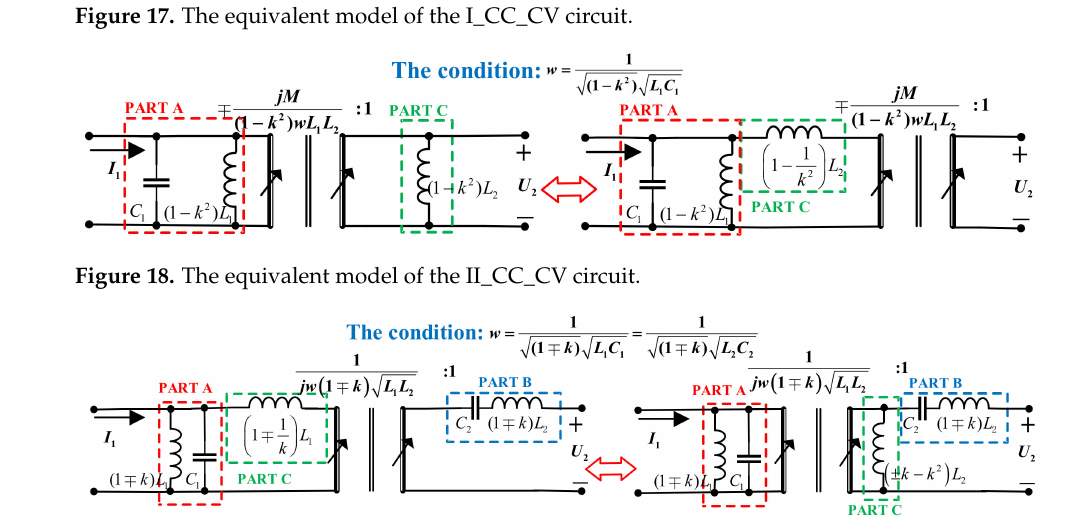
Figure 19. The equivalent model of the III_CC_CV